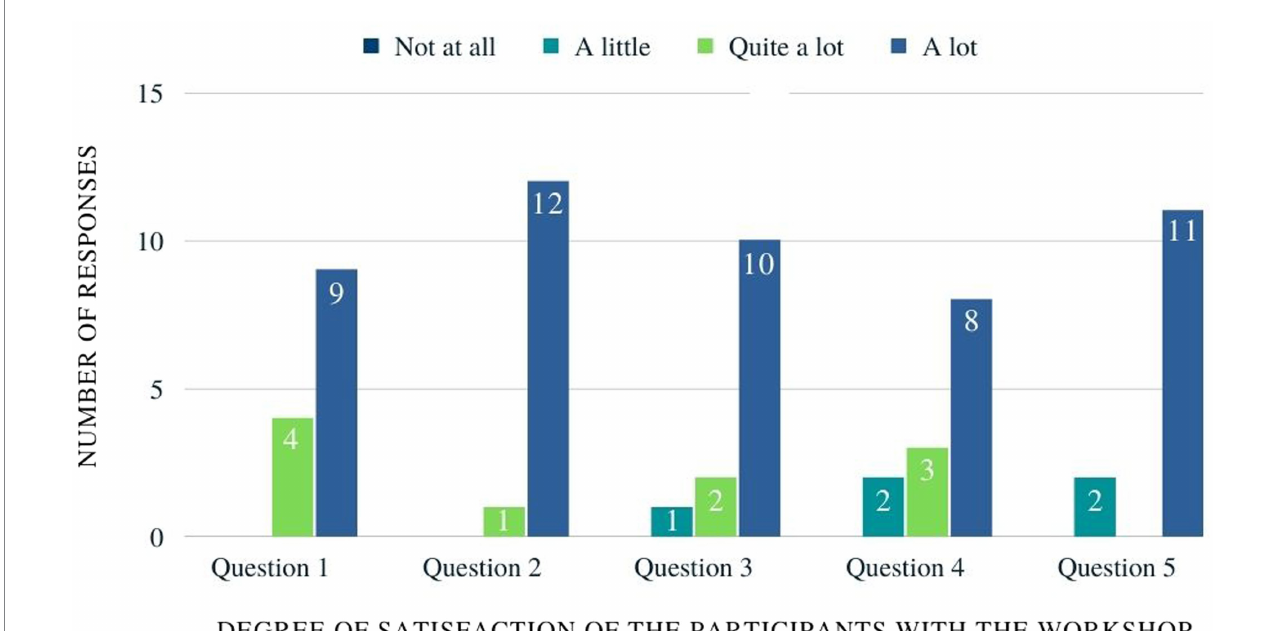
FIGURE 3 Degree of satisfaction of the child participants with the